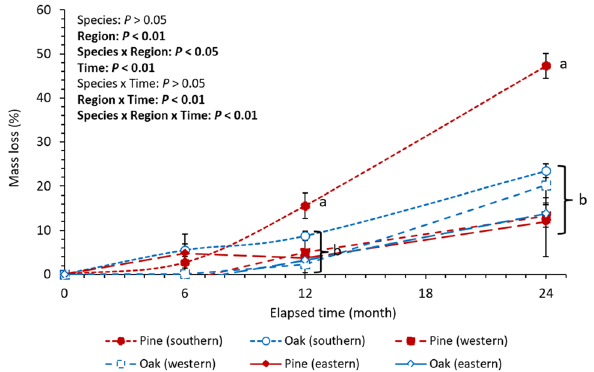
Figure 2. Mass loss of deadwood samples within the study period (24 months). Letters next to points show statistical differences between the mass losses within a given time (n = 9 for each species within a given region and time, P < 0.05). Vertical bars indicate standard